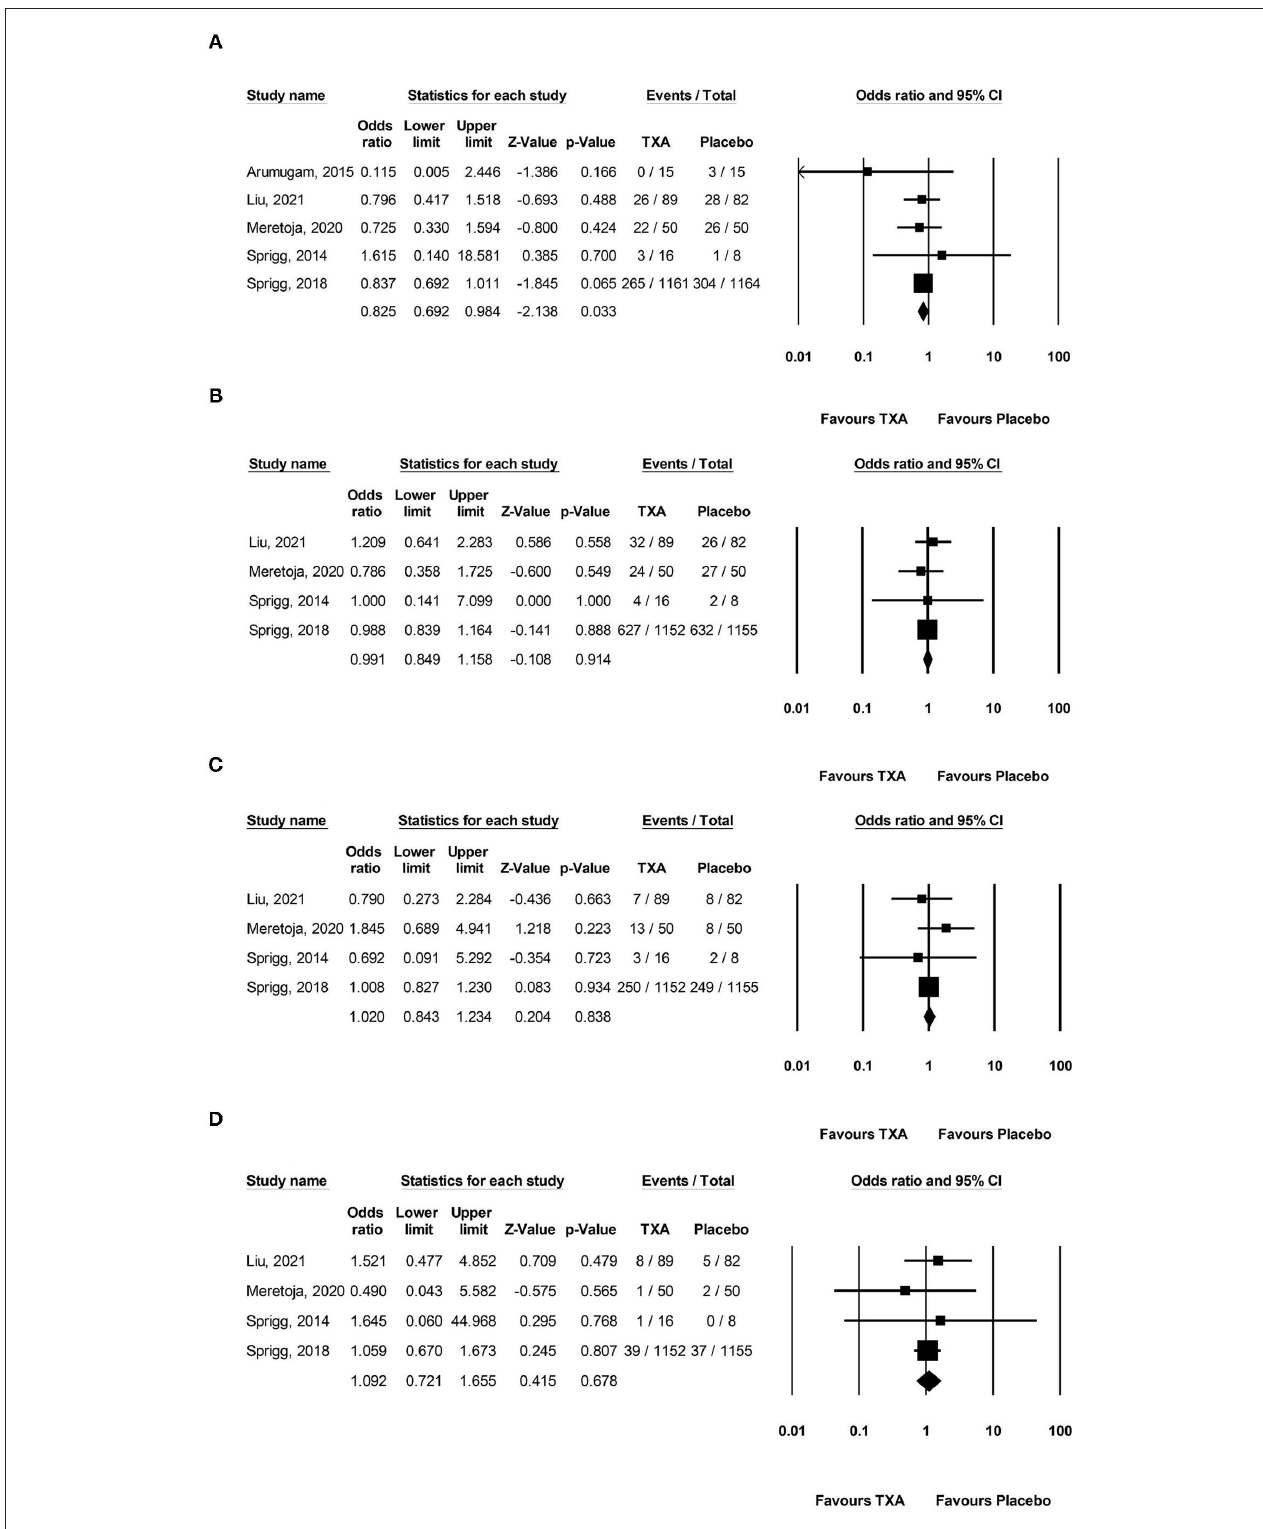
FIGURE 3 | Forest plot comparing the risk of (A) hematoma expansion, (B) 3-month poor functional outcome, (C) 3-month mortality, and (D) major thromboembolic events between the TXA and placebo groups. TXA, tranexamic acid.